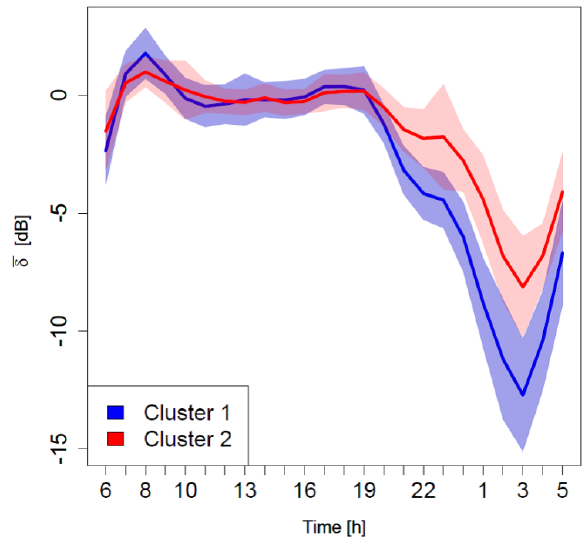
Figure 5: Mean normalized noise cluster profiles, δ and the corre- sponding standard deviation band.